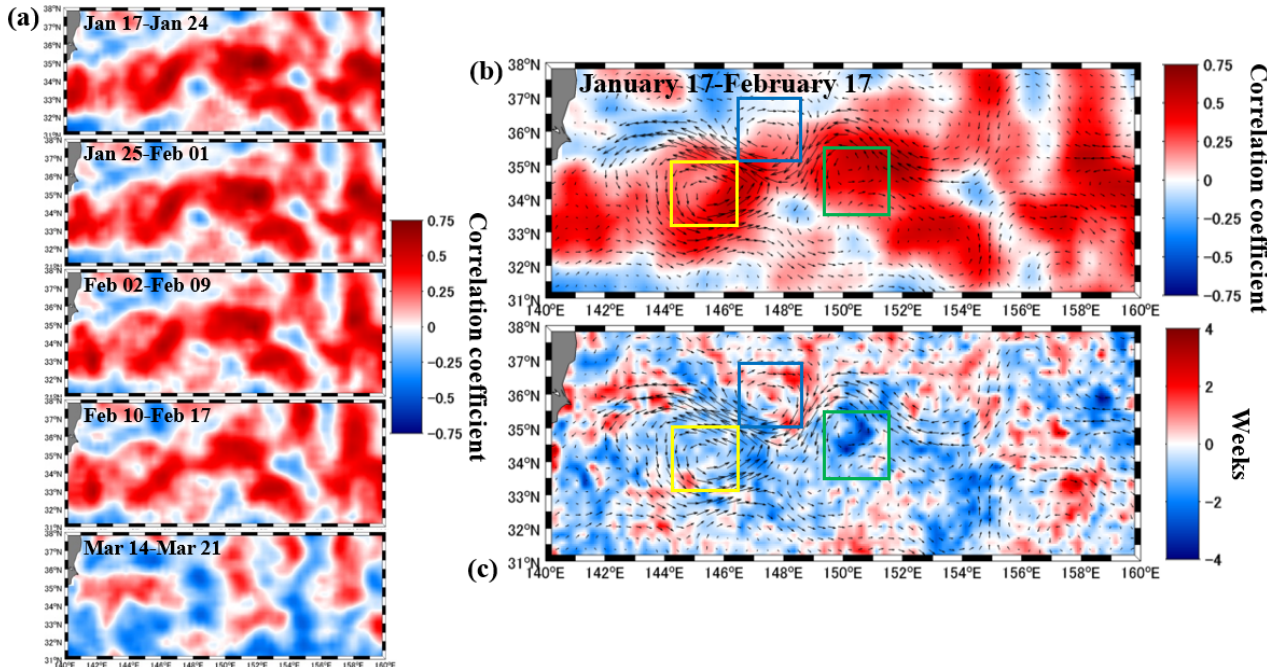
Figure 4. Maps of correlation coefficients between winter sea surface height anomalies (SSHAs) and onsets of the spring bloom. In ( a ) from top to bottom, analyses were conducted using mean SSHAs observed during 17–24 January, 25 January–1 February, 2–9 February, 10–17 February, and 14–21 March. Panel ( b ) is the same as ( a ), except that the SSHAs were averaged from 17 January to 17 February. Panel ( c ) is the mean spring bloom onset difference ( Δ onset) between the periods of unstable and stable Kuroshio Extensions (KEs) calculated by subtracting mean spring bloom onset during years of stable KEs from the mean spring bloom onset during years of unstable KEs. Vectors overplotted on ( b , c ) are winter (January–March) ocean surface current differences between the periods of unstable and stable Kuroshio Extensions (KEs) based on Ocean Surface Current Analysis Real-Time data. The yellow, green, and blue boxes shown in panels ( b , c ) represent the areas from which the data were extracted to be shown in Figure 5.